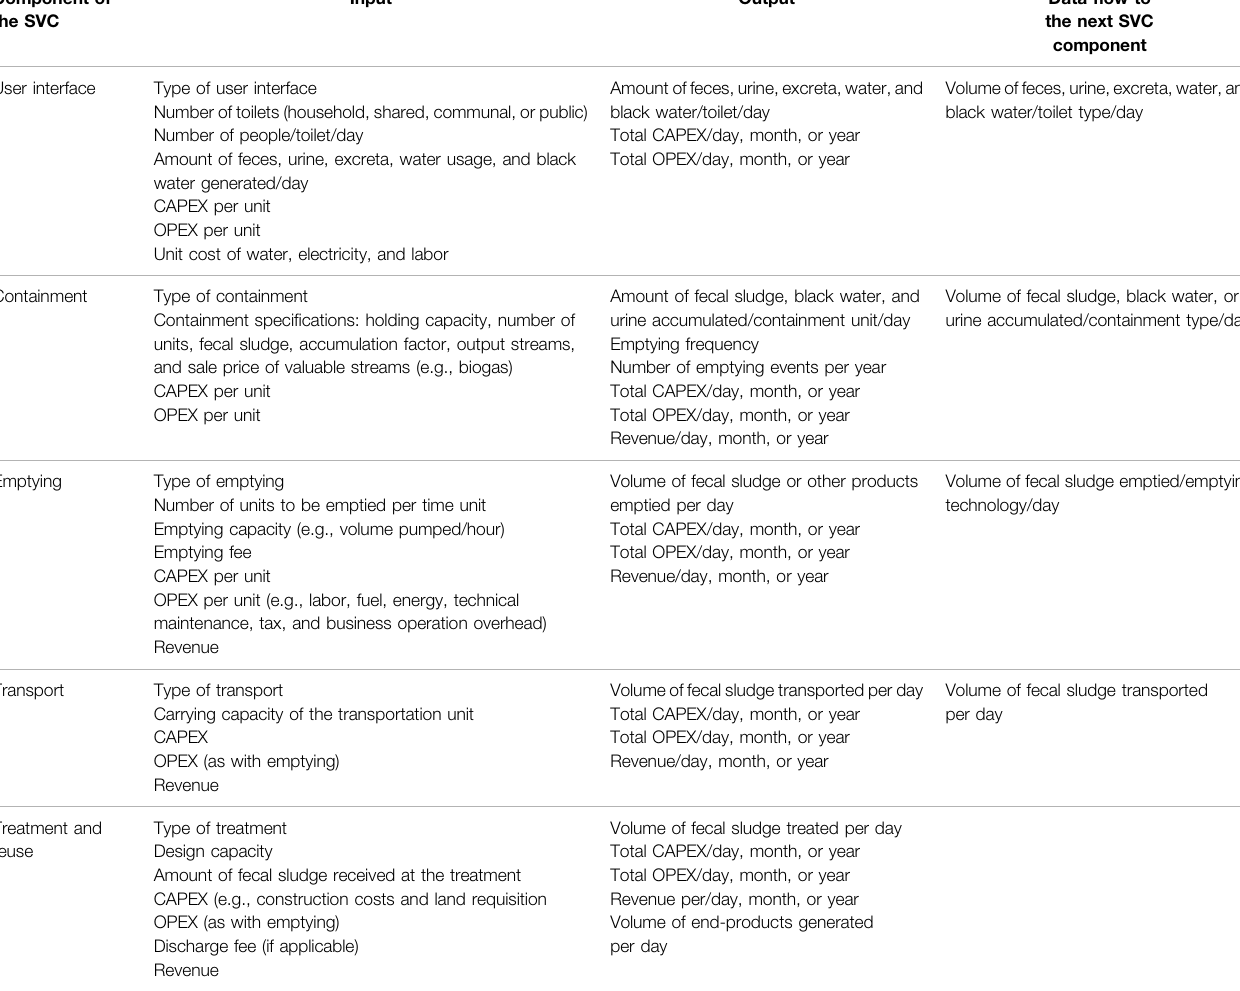
TABLE 2 | Summary of input, output, and links to the next SVC component in eSOSView ™ (Furlong et al., 2020). Component of the